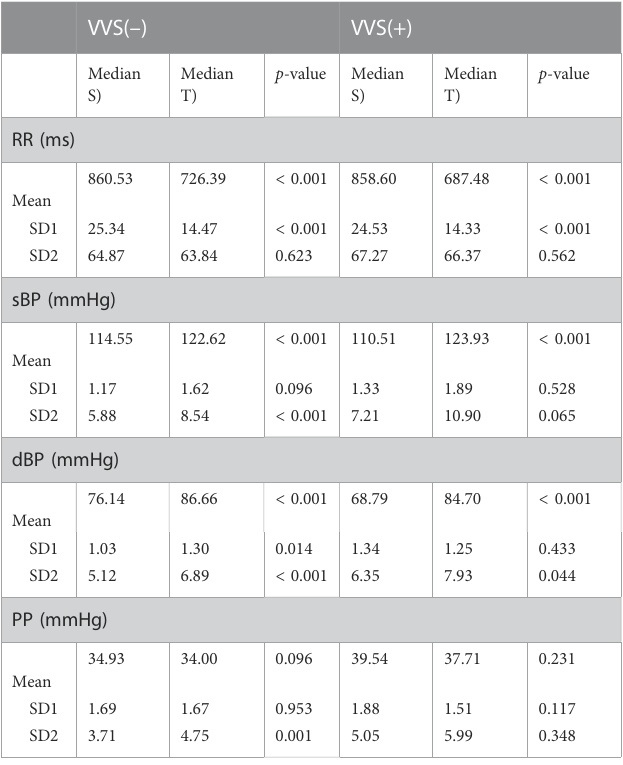
TABLE 2 The comparison of the median of heart rate (RR interval) and blood pressure (systolic, sBP; diastolic, dBP; and pulse pressure, PP) variability descriptors between supine (S) and tilt (T) phases of the head-up tilt test in the vasovagal patients ’ group (VVS (+)) and control group (VVS ( – )). The variability descriptors are beat-to-beat and slow variability (SD1 and SD2, respectively) and mean values of the biosignal obtained for each